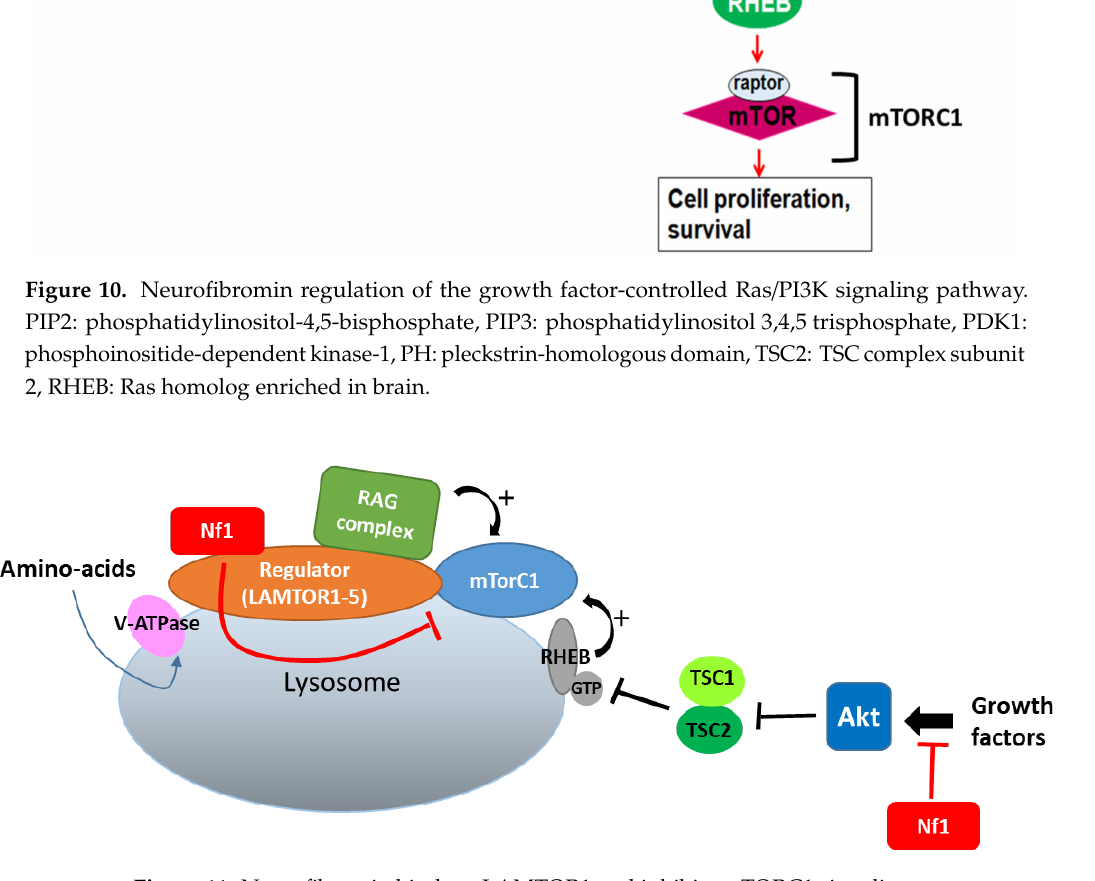
Figure 12. Neurofibromin mediates cross talk between GPCR (opioid receptors) and Ras/AKT signaling [132] . 7.5. Control of Actin Cytoskeleton Organization Actin exists in two forms, monomeric G-actin and polymeric F-actin. The fine-tuning of actin polymerization/depolymerization is important for the regulation of crucial biological processes, such as cell morphology and motility. Cofilin, a member of the ADF family (actin depolymerizing factor), depolymerizes actin by severing aged actin filaments. Phosphorylation of cofilin by LIM kinases (LIMK1 and LIMK2) inactivates its actin-severing activity, resulting in the stabilization of actin filaments, an increase in the number of stress fibers, and focal adhesion formation [133,134]. Aside from its Ras-GAP activity, neurofibromin plays an important role in regulating cytoskeletal organization. Specifically, neurofibromin regulates the dynamic reorganization and